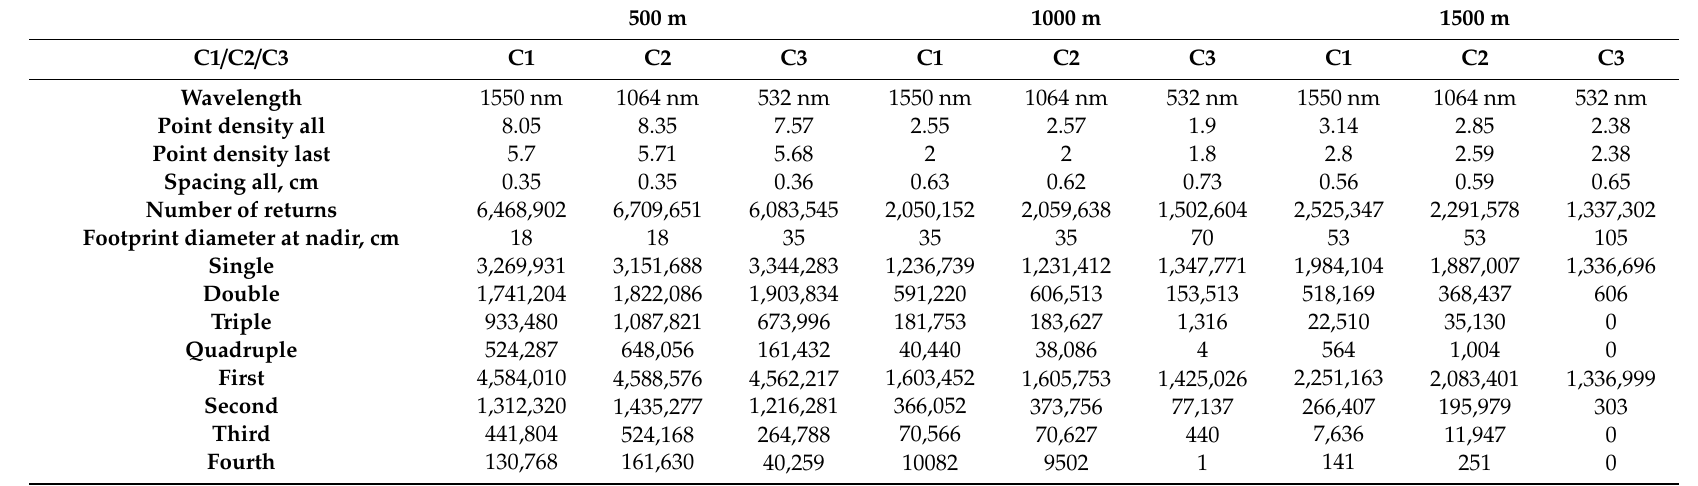
Table 2. Summary table of the Lidar dataset (note that statistics is given for all points in